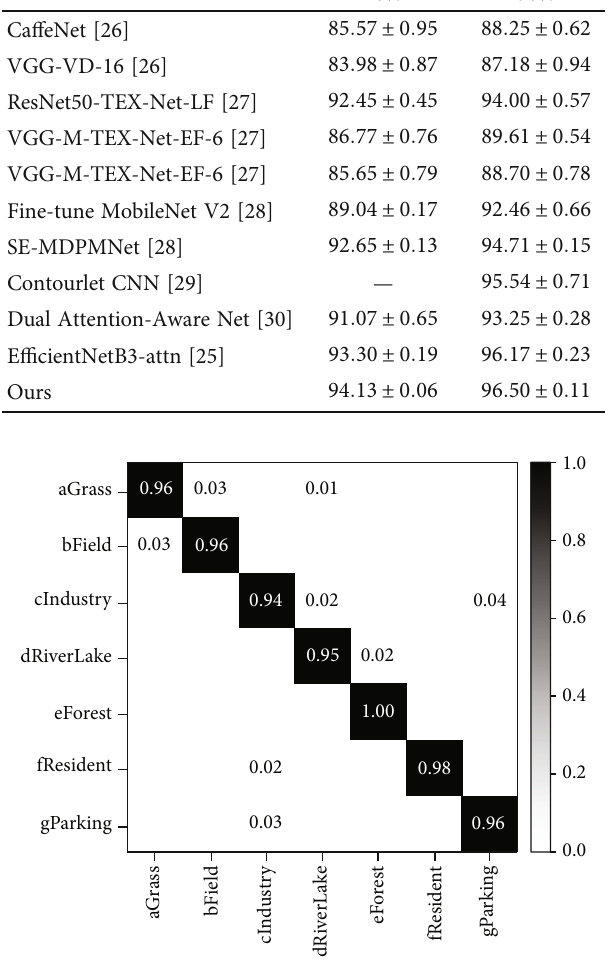
Figure 5: Confusion matrix under the 50% training ratio on the RSSCN7 data set.